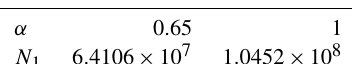
Table 2. Lognormal parameters for the present LSSF and SSSF. Refer to Eq. (8).